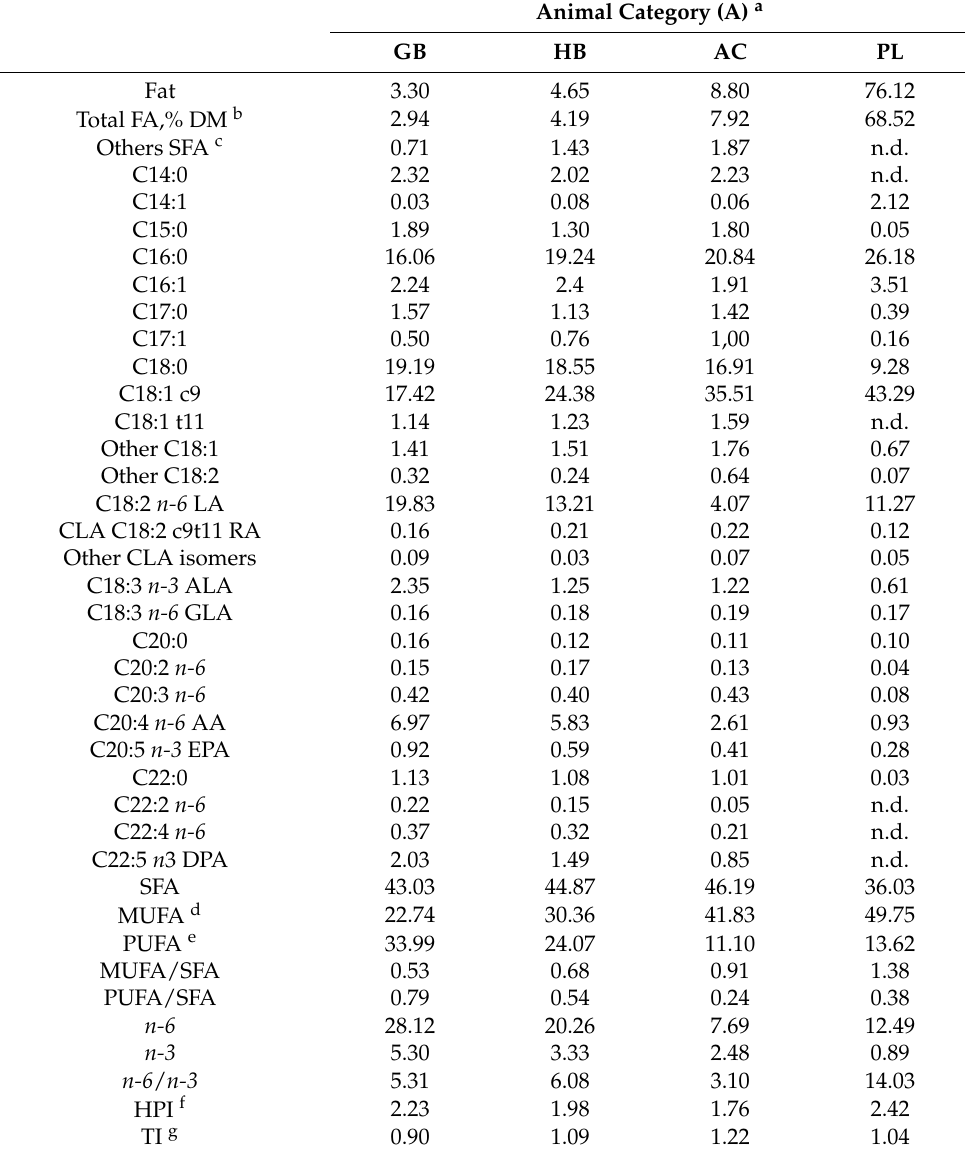
Table 1. Fatty acids profile (% of total FA) and health indexes of fresh meat and fresh pork